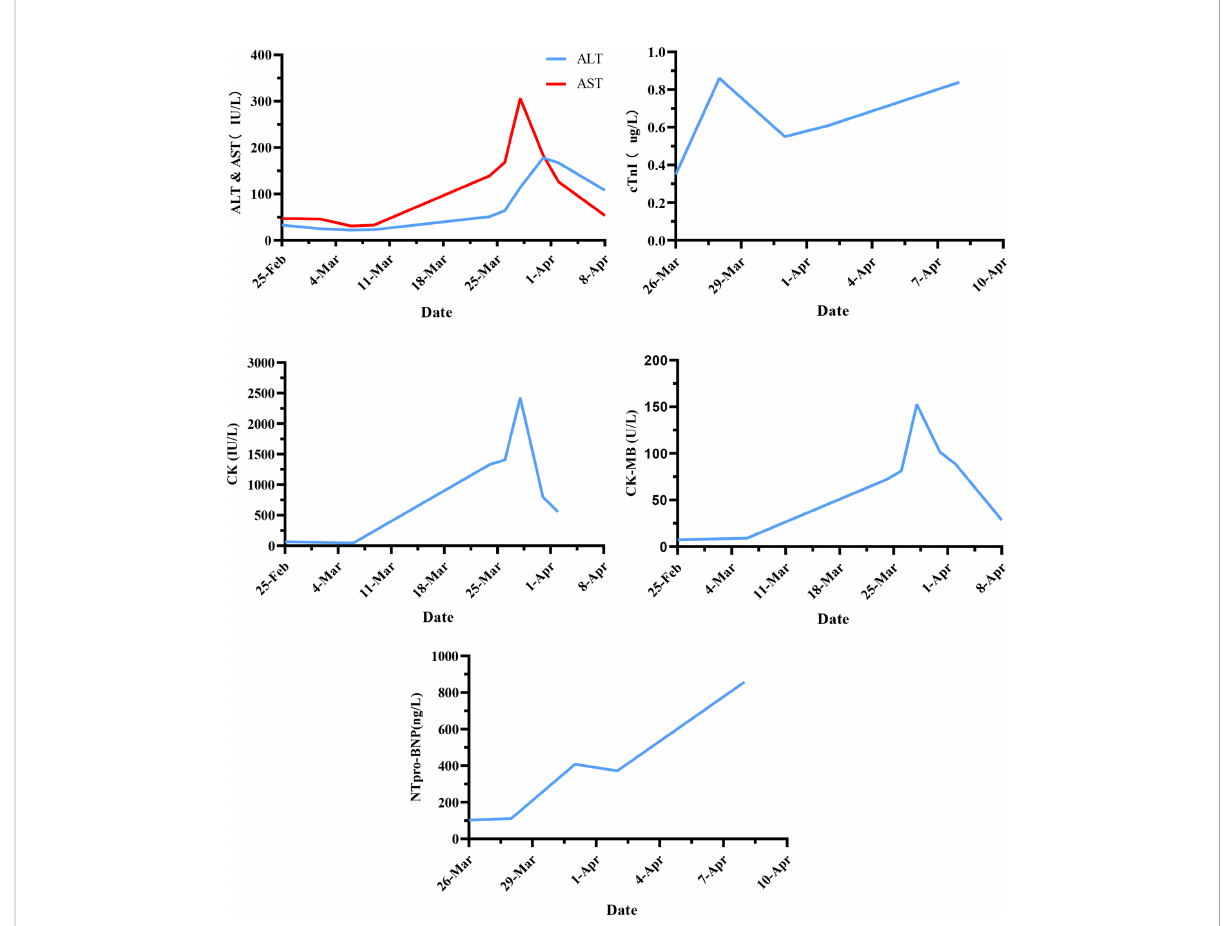
FIGURE 2 The changes in serum enzyme levels during the treatment (x-axis = date, y-axis = units